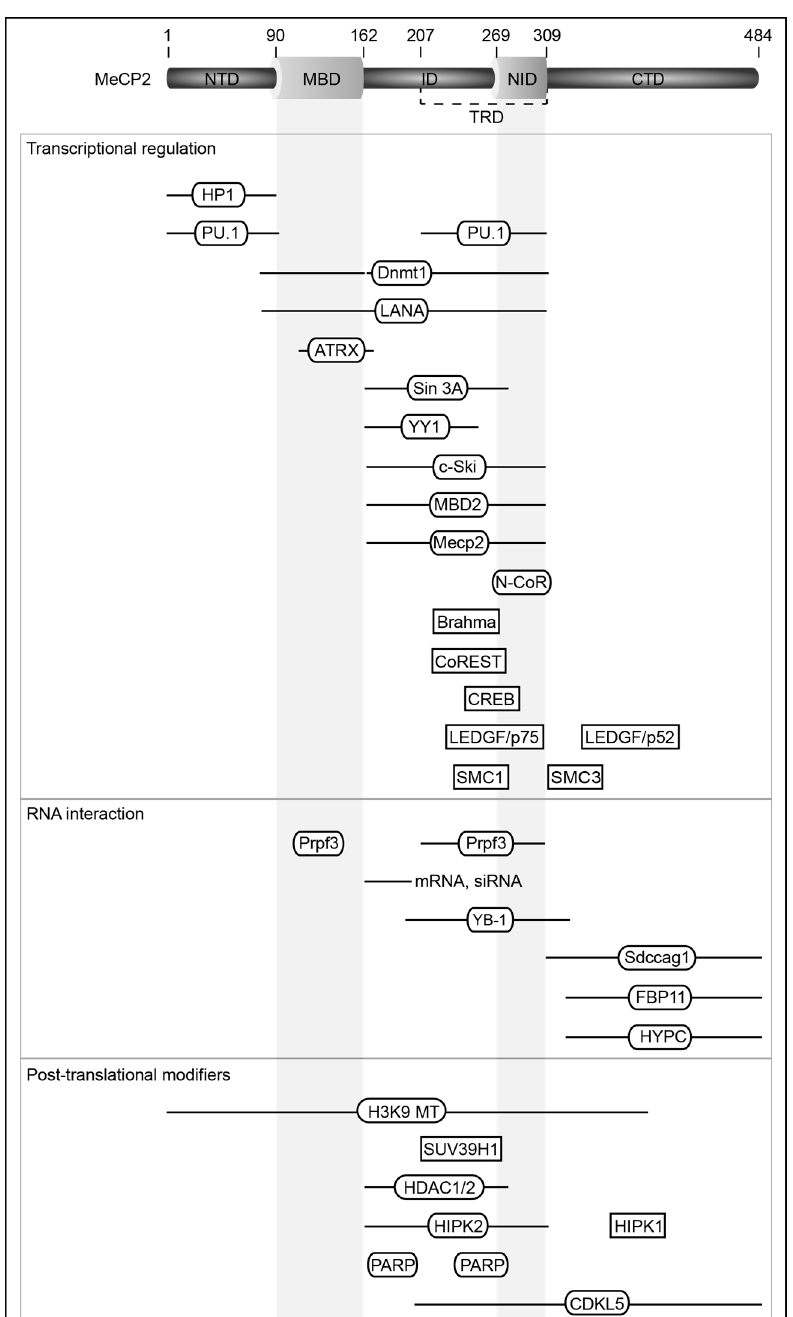
Figure 1. Overview of MeCP2 interaction partners. MeCP2 interaction partners, group by main function and ordered by where they interact within MeCP2, if known. References are given in Table 1. Rectangles indicate proteins with no mapped interaction region within MeCP2. NTD: N-terminal domain; MBD: methyl binding domain; ID: intervening domain; NID: N-CoR interacting domain; CTD: C-terminal domain; TRD: transcriptional repression domain. Amino acid labeling according to mouse MeCP2 isoform e2. Protein domain structure generated using DOG 1.0 software [61].